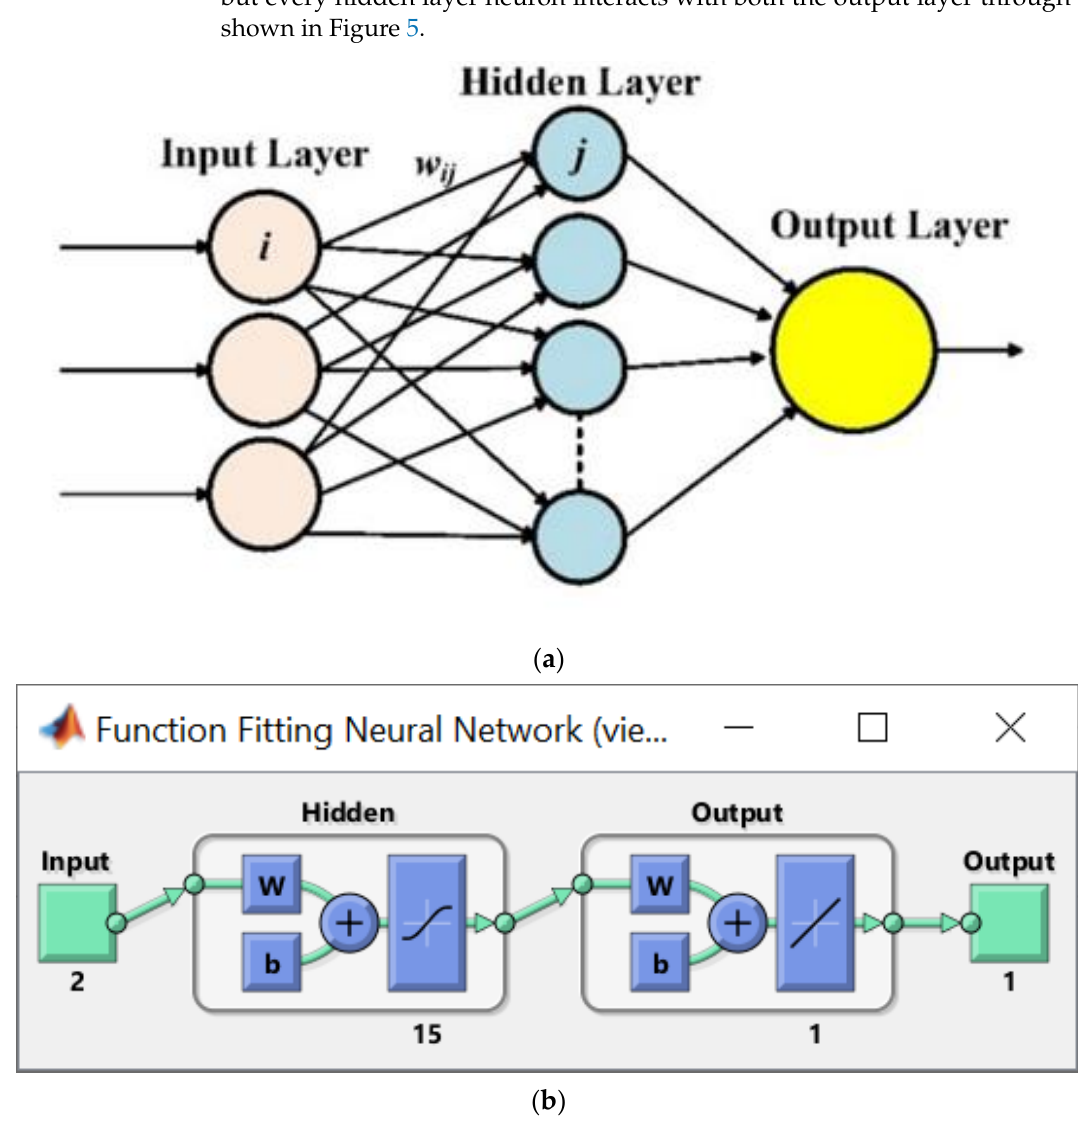
Figure 5. Modeling the tested NN: ( a ) configuration; ( b ) architecture of LM.